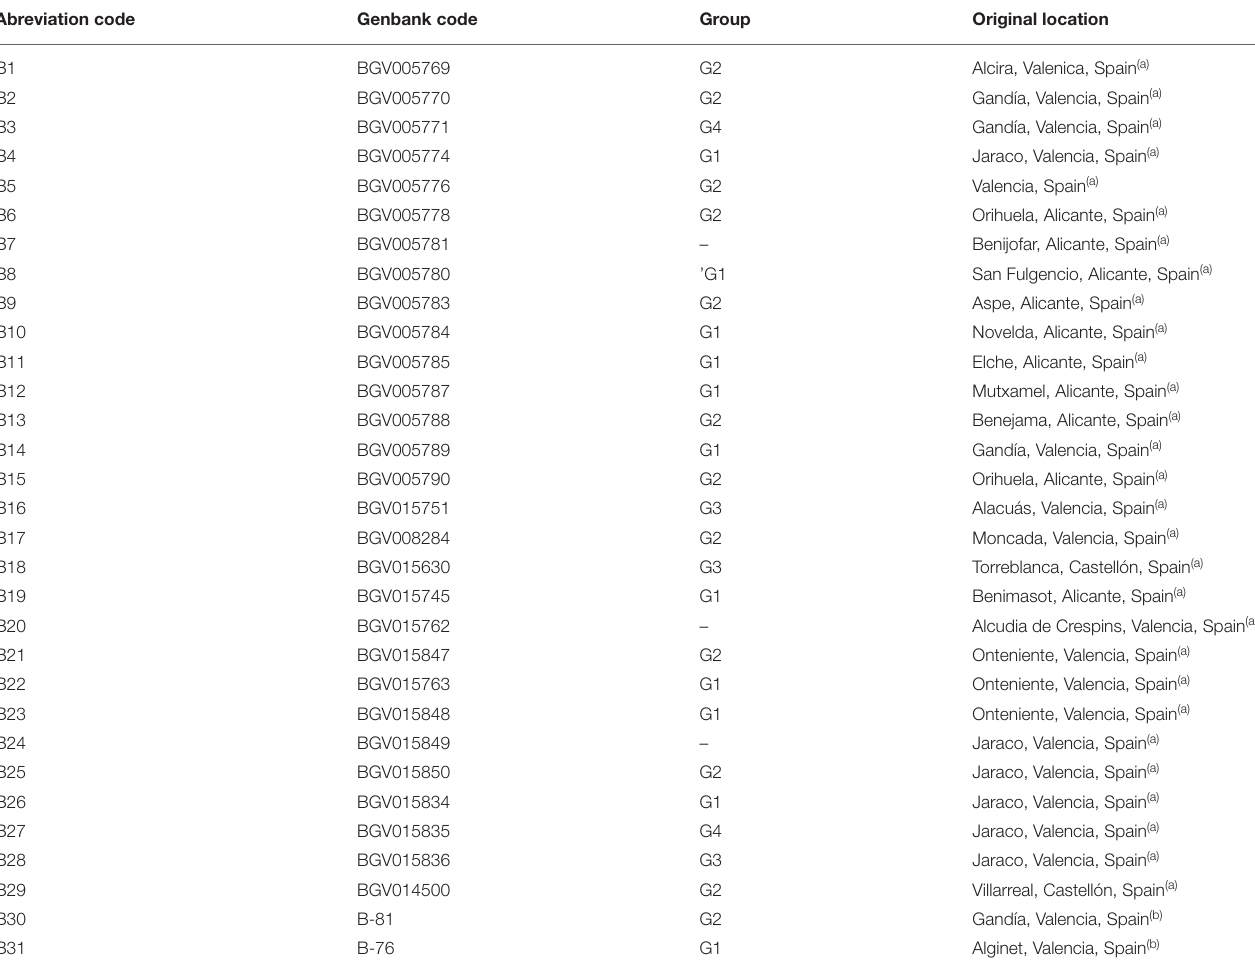
TABLE 1 | Abbreviation, germplasm collection code, group (based on eggplant skin colour, G1 = black-purple, G2 = striped, G3 = white, G4 = reddish purple) and origin of the 31 eggplant landraces used in the